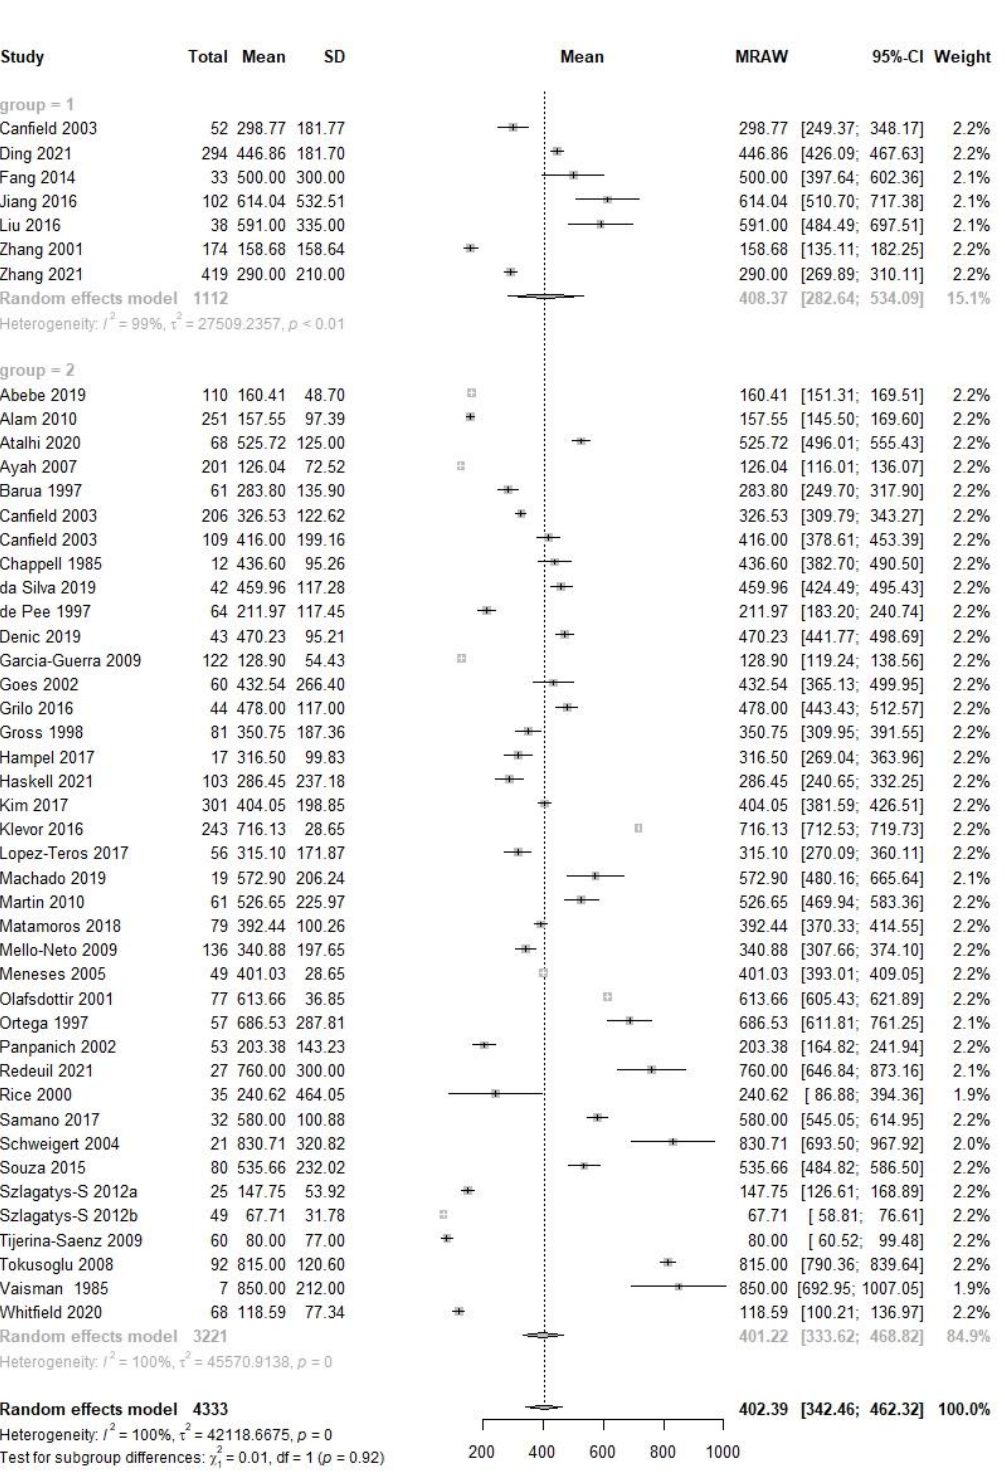
Figure 4. Forest plot of early mature human milk VA concentration and subgroup analysis between Chinese and non-Chinese samples.